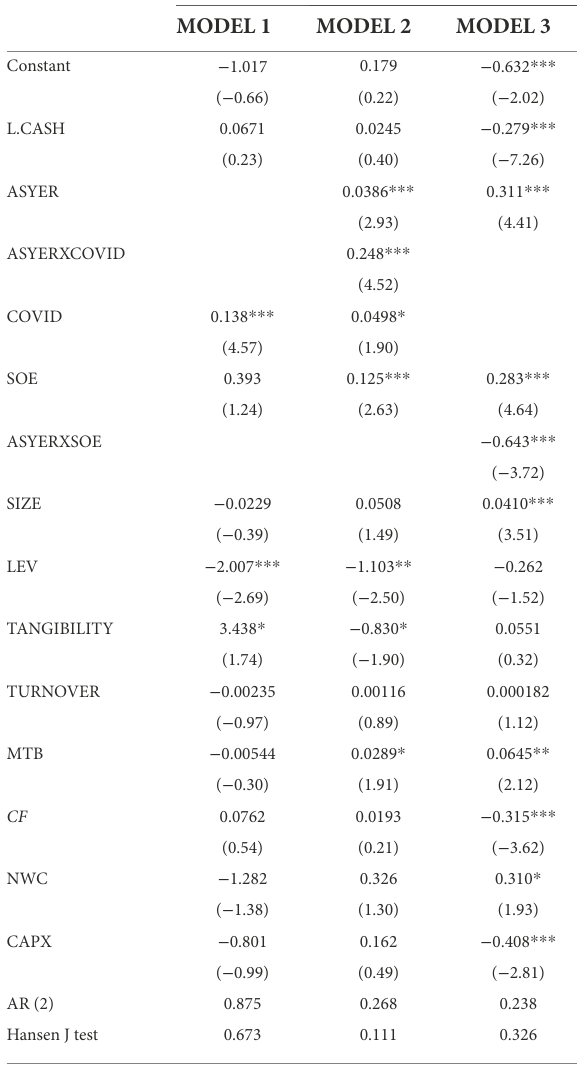
TABLE 10 Robustness checks using two-step